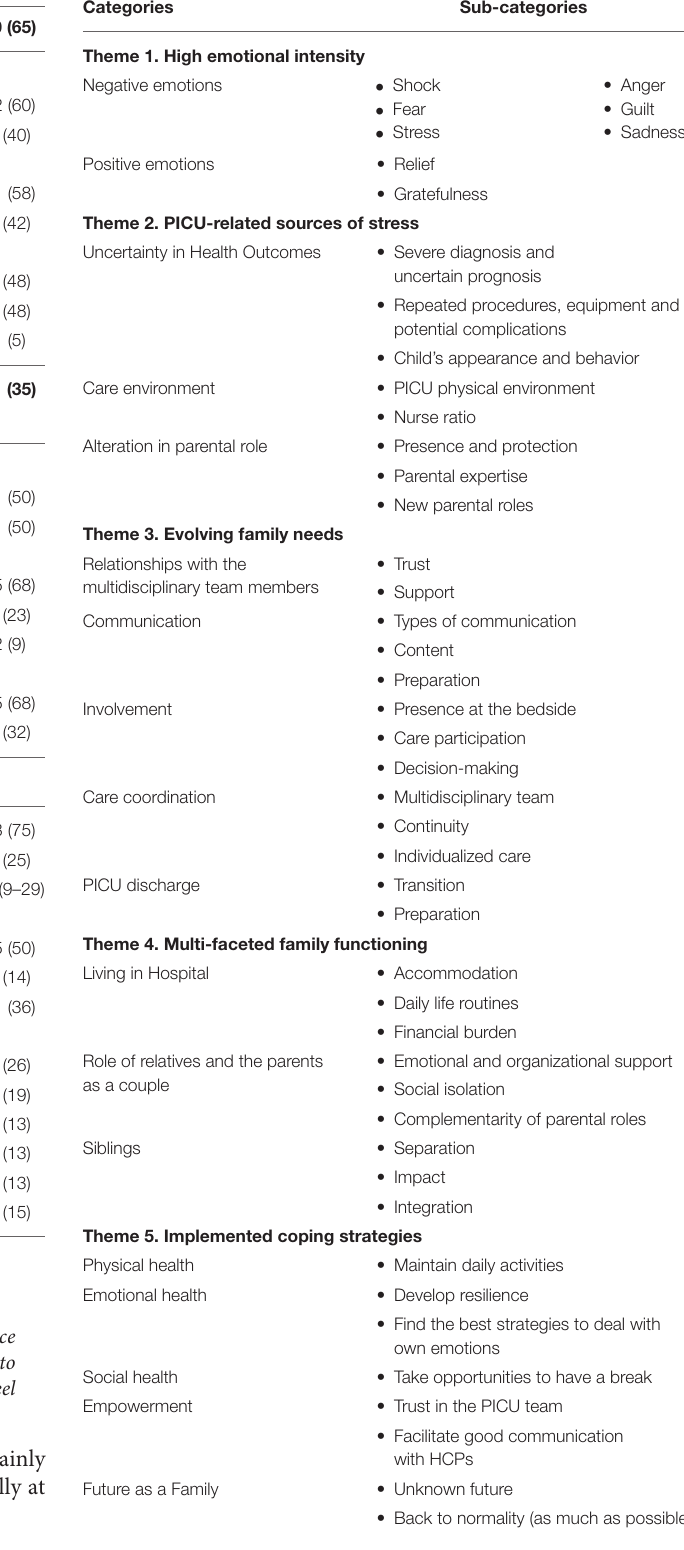
TABLE 2 | Themes, categories and sub-categories resulting from data